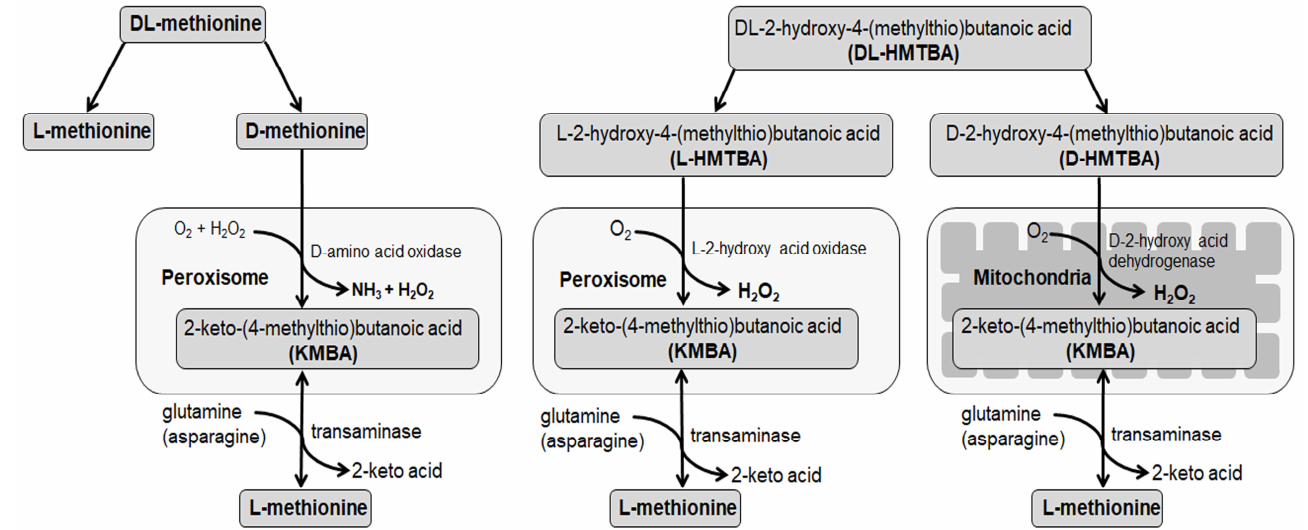
Figure 1. Schematic overview on methionine isomers and precursor transformation pathways.